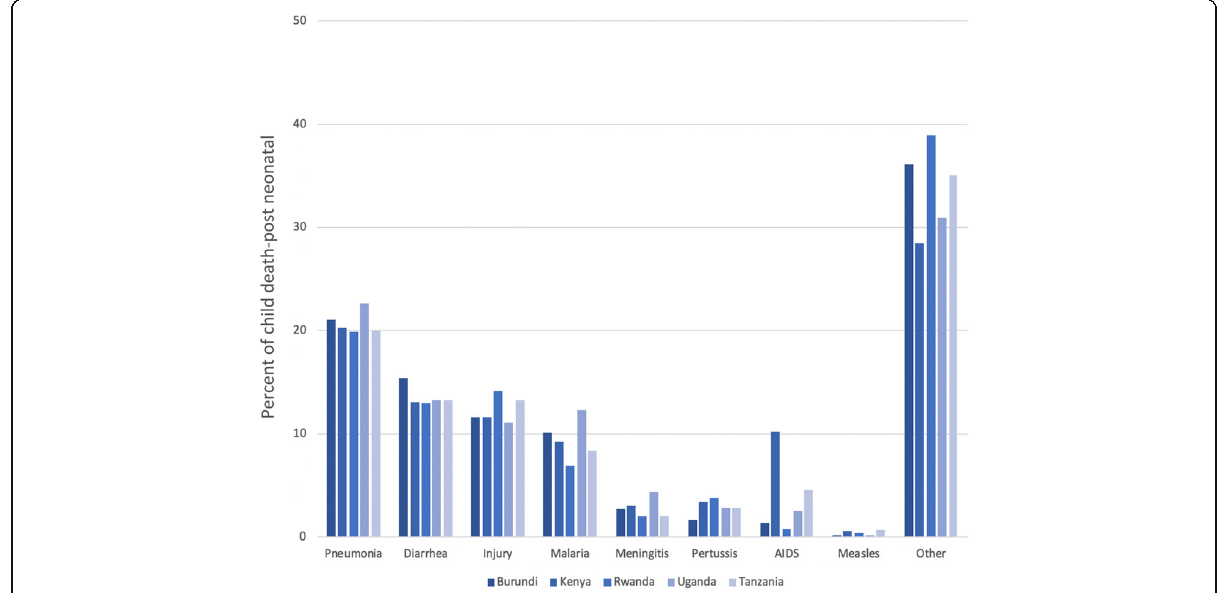
Fig. 2 Percent of child death-post neonatal by proximate causes across East African Community (2014/2015). Source: Lives Saved Tool. While the details for ‘ Other ’ in the Fig. 2 was not provided in LiST, drawing on existing literature of global burden of diseases, injuries and risk factors, we believe that this section would include malnutrition, congenital anomalies, drowning, and foreign bodies